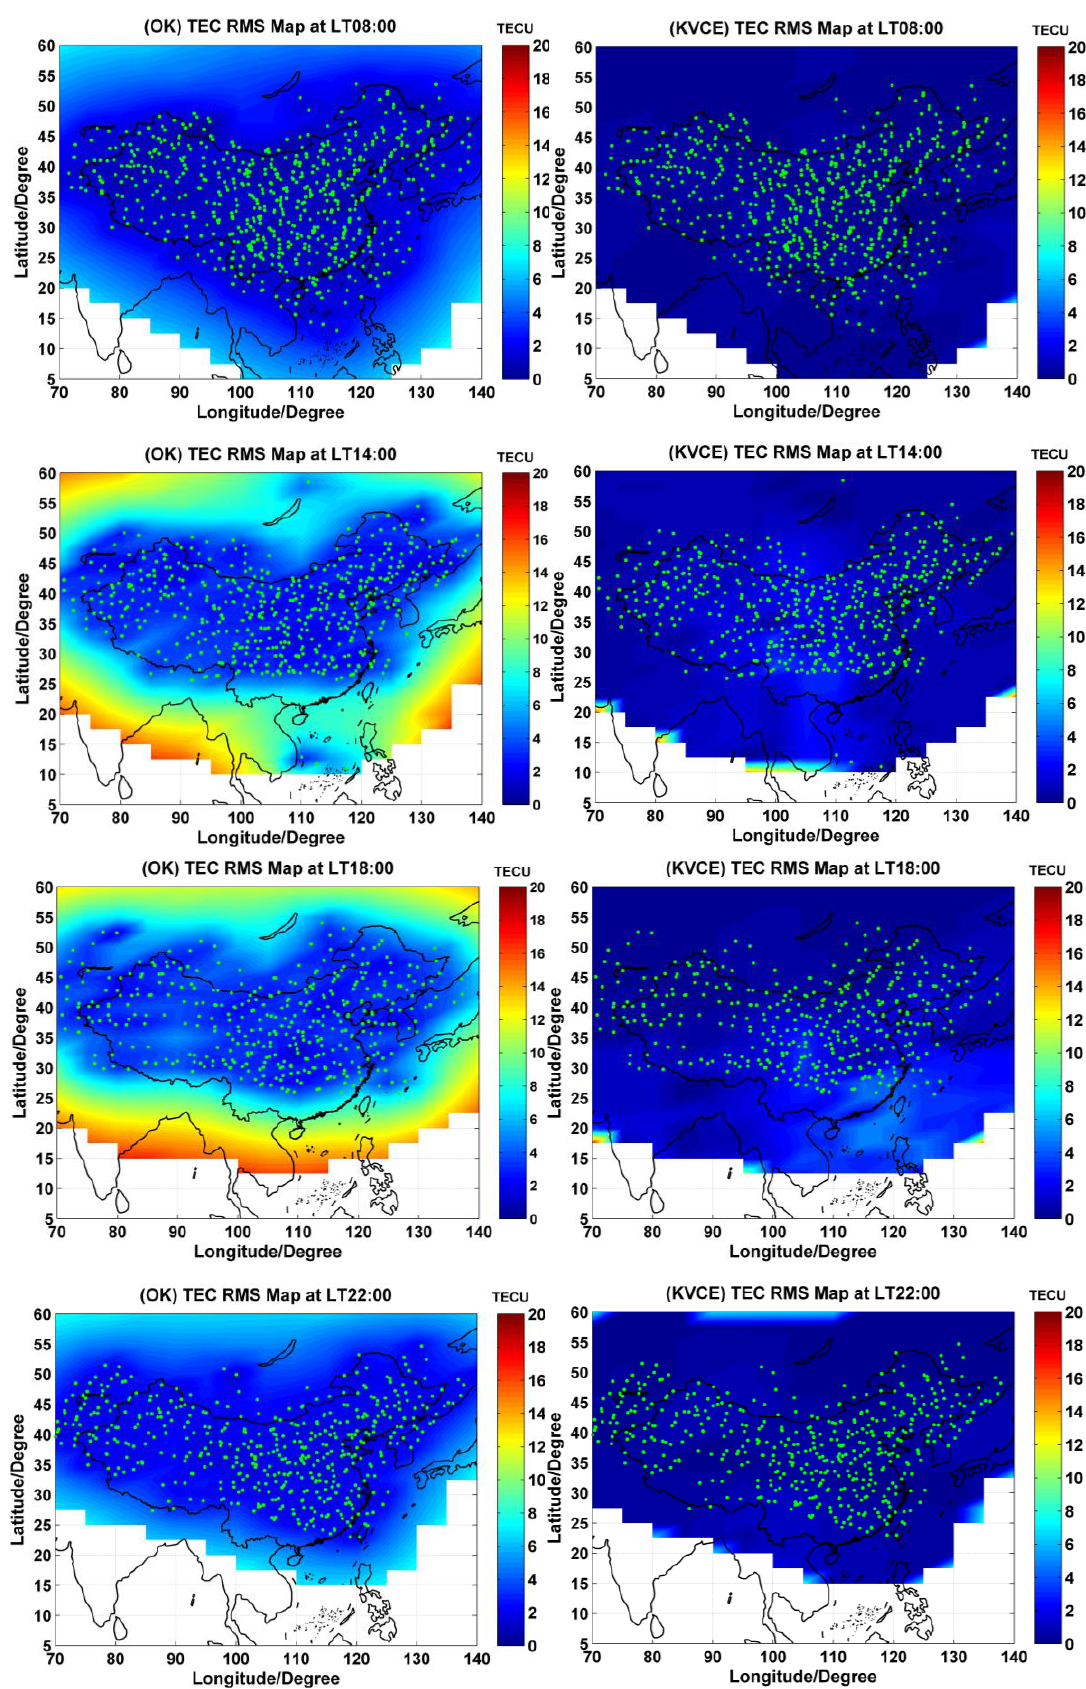
Figure 9. The grid sigma estimated by OK at different local time (left column) and KVCE (right column) on DOY 305.